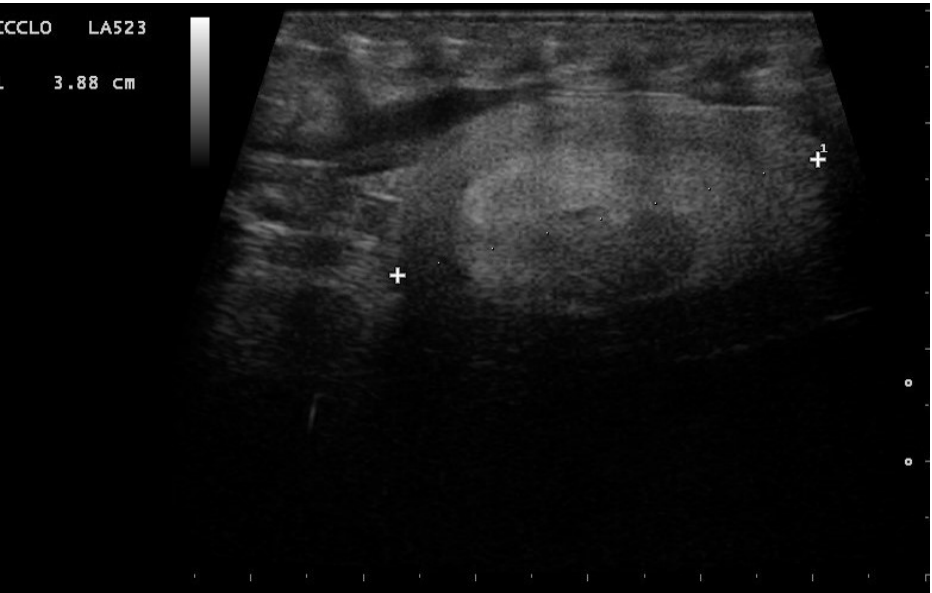
Figure 7 . Follicle highlighted in a female boa 24 days after ovulation. Due to the alternation of areas with different echogenicity, an onion ring appearance is highlighted in 96.2% of females who have given birth to living and viable offspring.